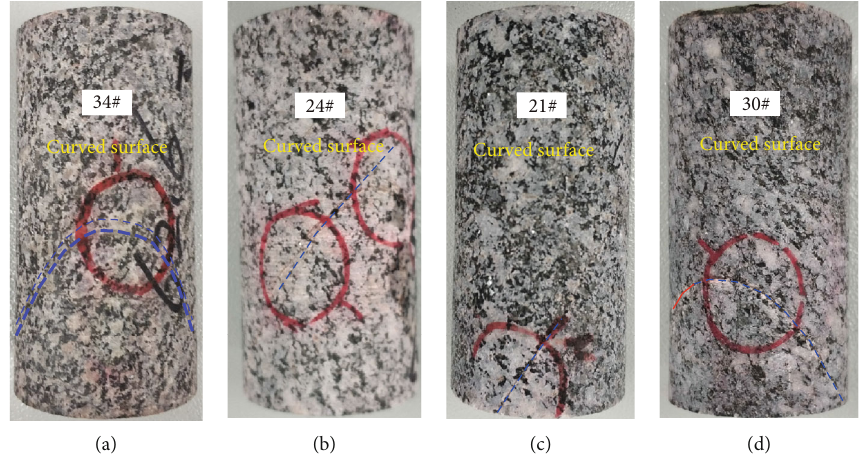
Figure 3: Typical granite samples used in the increasing amplitude stress-cycling experiments. The natural fractures are schemed in blue color on the curved surface.